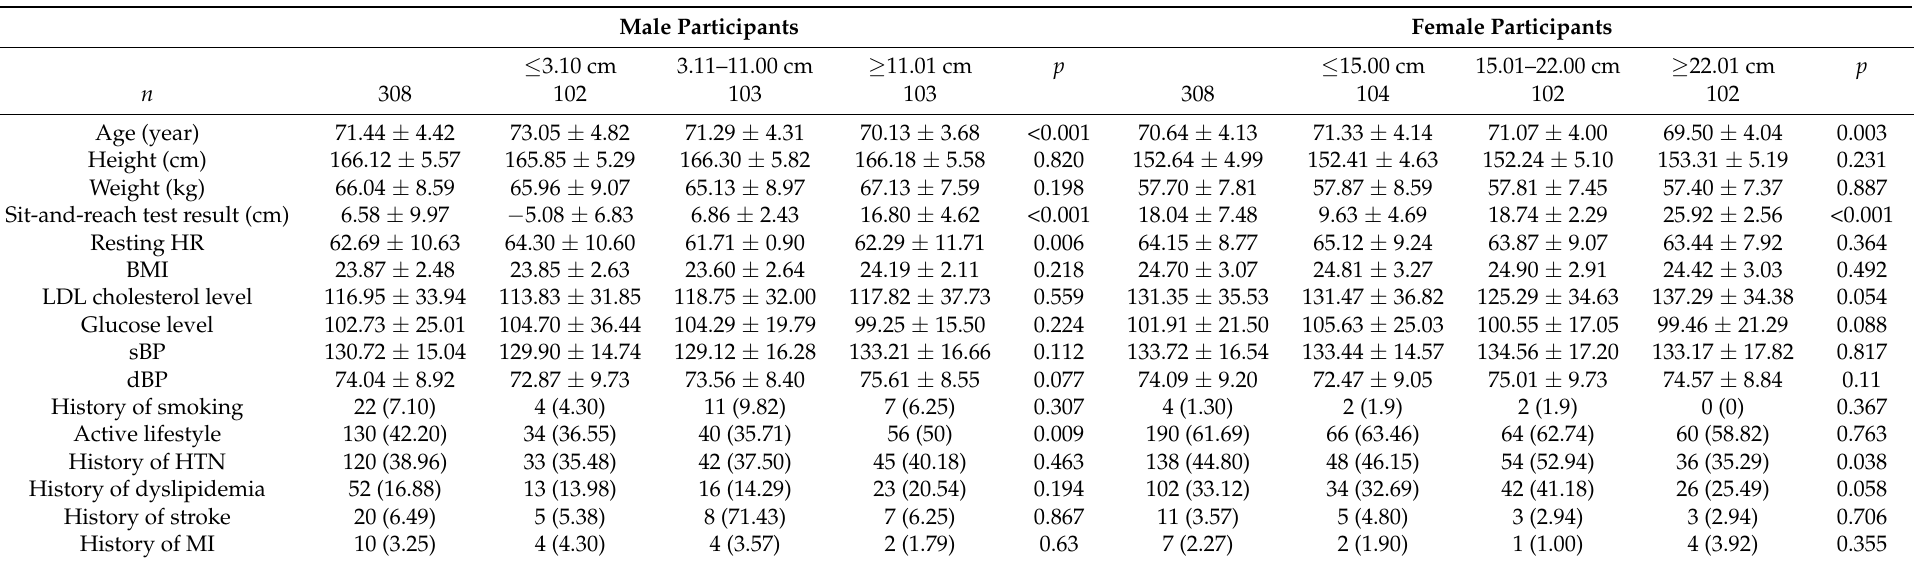
Table 1. Baseline